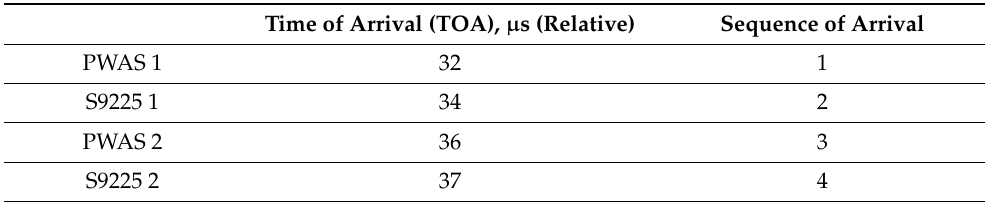
Table 2. Time of arrival and sequence of arrival of sampe T2 AE signal at various Sensors. PWAS-1 and S9225-1 are the closest to the crack. Hence, AE signals first arrive at PWAS-1 and S9225-1 approximately at same time. PWAS 2 and S9225-2 are at 25 mm from the crack. Hence, AE signals arrive approximately at the same time at PWAS-2 and S9225-2. This analysis confirms that AE signals originate from the crack. Time of Arrival (TOA), µs (Relative) Sequence of Arrival PWAS 1 76 1 S9225 1 78 PWAS